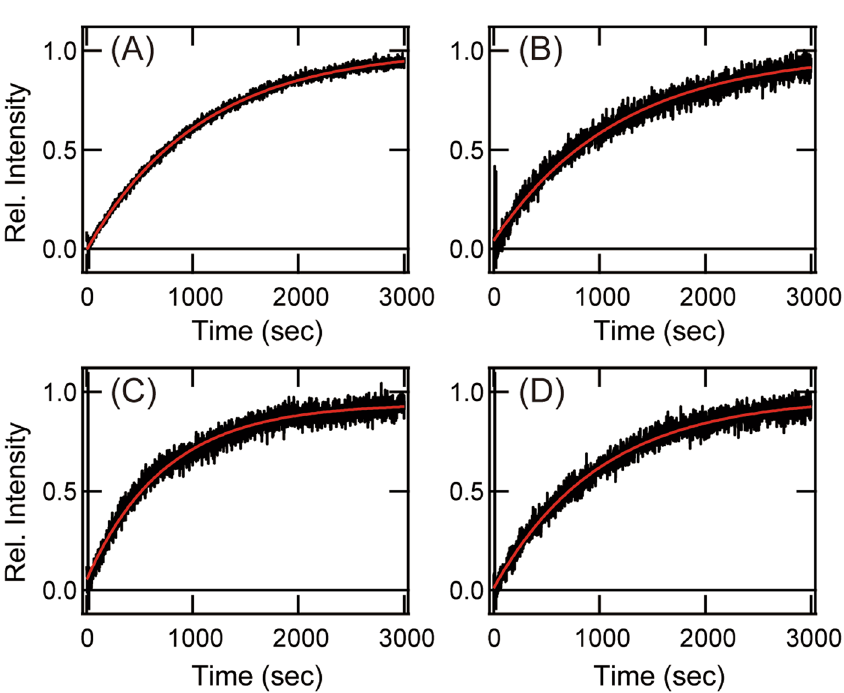
Figure 6. Comparison of the decay of meta II. Decay of meta II of bovine Rh1 ( A ), gray bichir Rh1 ( B ), spotted gar Rh1-2 ( C ) and spotted gar Rh1-1 (Exorh) ( D ) was measured by monitoring the change of intrinsic tryptophan fluorescence after yellow light ( > 500 nm) irradiation (black line). The data were fitted by a single exponential function (red curve) to estimate the decay rate as follows; bovine Rh1, 875 ± 108 sec; gray bichir Rh1, 913 ± 113 sec; spotted gar Rh1-2, 668 ± 74 sec; spotted gar Rh1-1 (Exorh) 894 ± 129 sec. The average and S.E.M. were calculated based on three independent